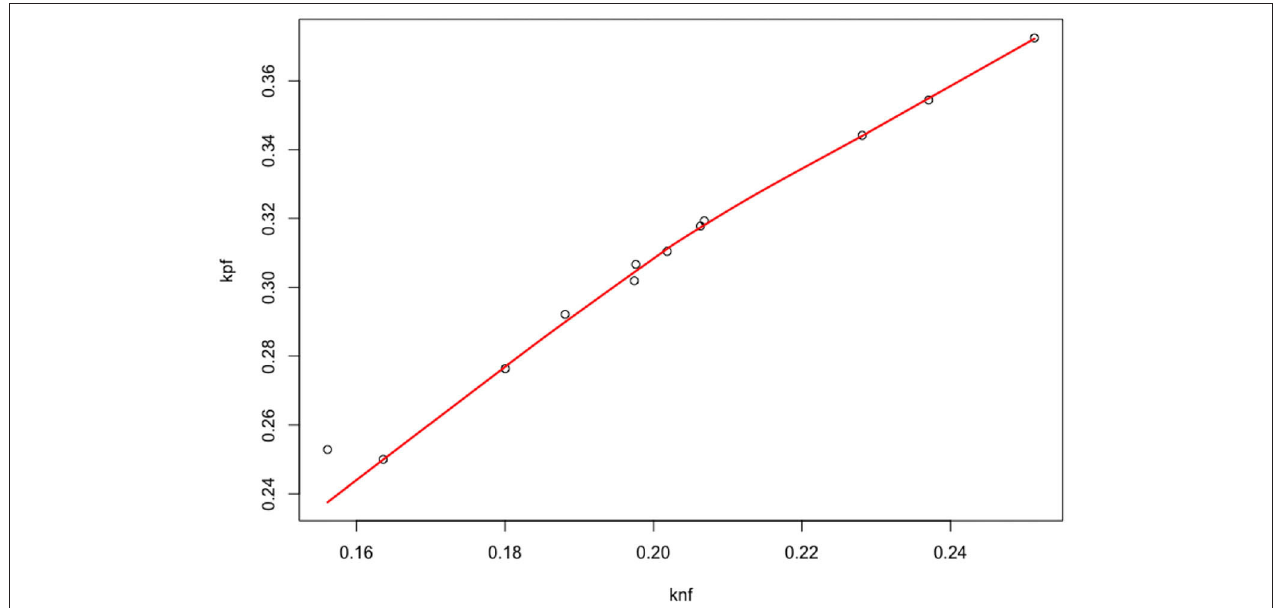
FIGURE 5 | Scatter plot of the individual parameters ( µ i , λ i